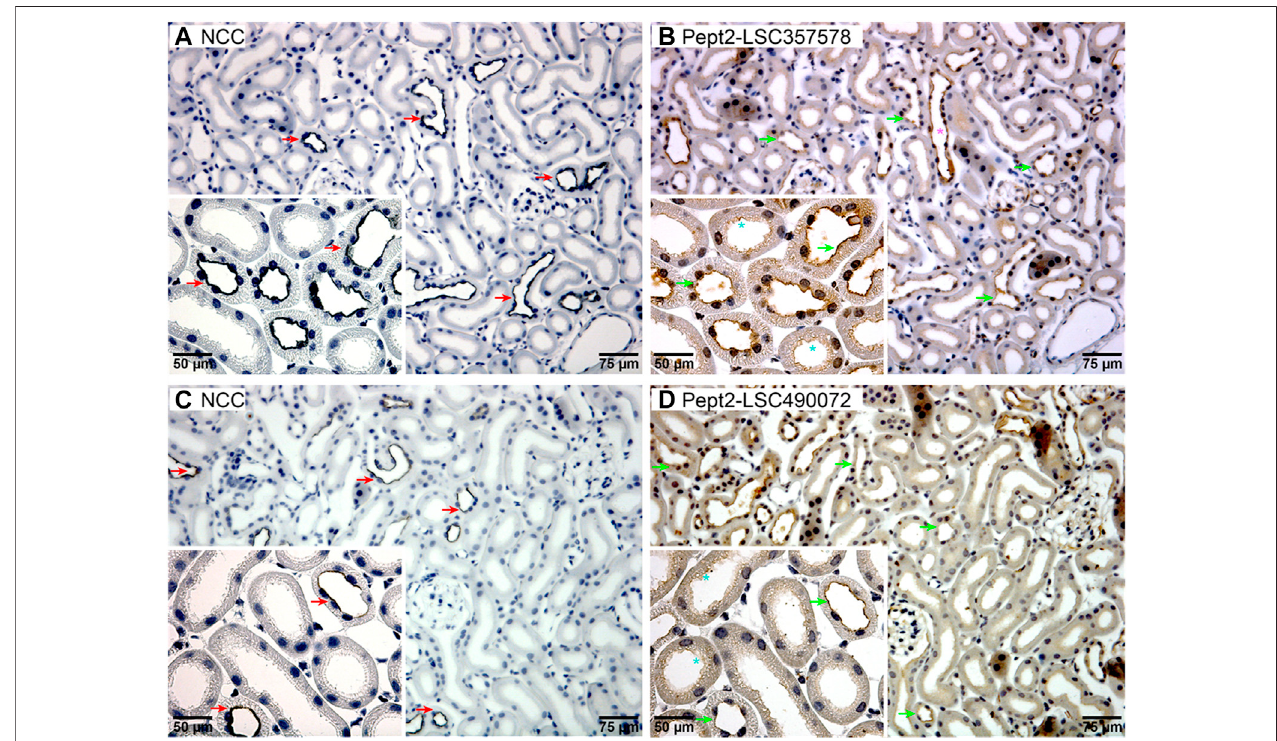
FIGURE4| Pept2 isexpressed inthe apical membrane ofmouse DCT. Serial sections from mouse kidney wereprobed withanNCC antibody (A,C) toidentify the DCT. Two different Pept2 antibodies (B,D) showed Pept2 in the apical membrane domain of the same segment as NCC as highlighted by the red and green arrows. Turquoise stars(*)mark proximaltubuleswhere Pept2isalsodetectedintheapicalbrushborder. Pinkstar(*) represents Pept2labeling ofthecollecting duct. Magni fi ed inserts are shown in left-hand